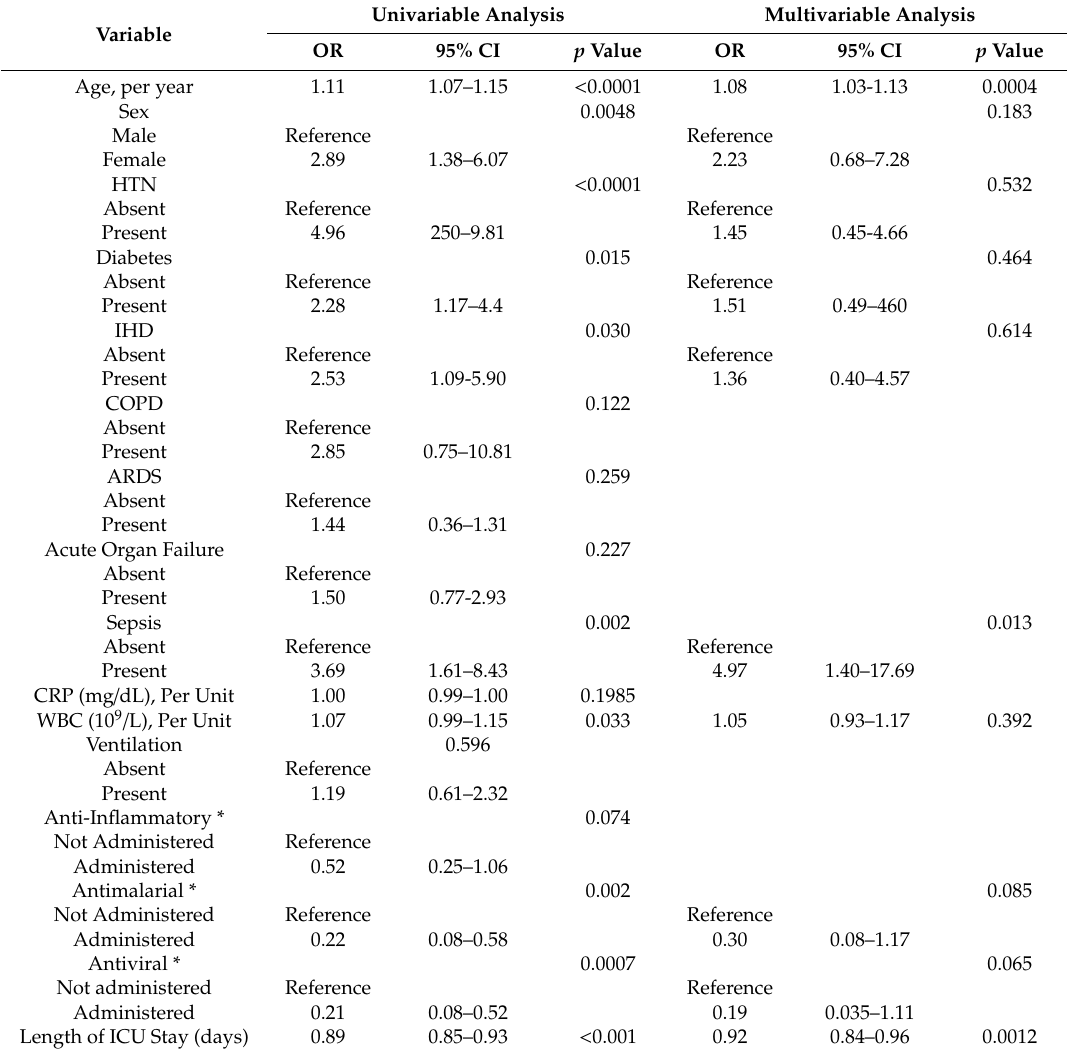
Table 4. Univariable and multivariable analysis of outcome in critically ill Covid-19 patients in the